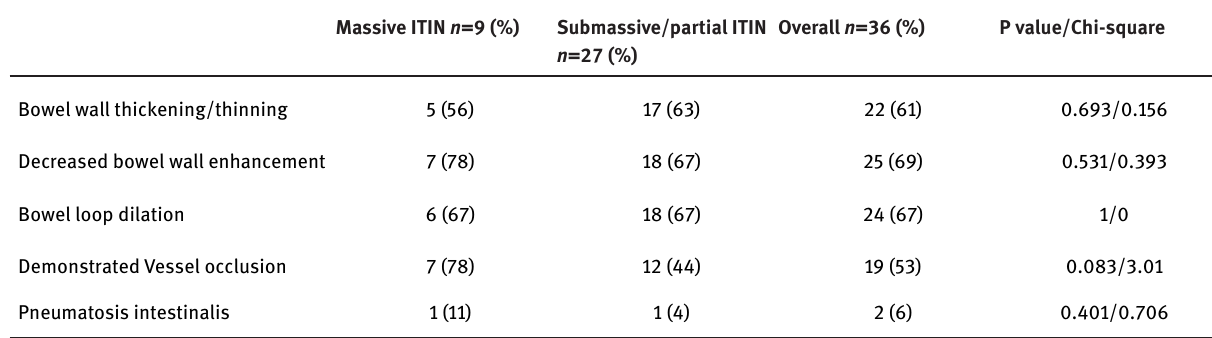
Table 4: Specific CT-scan signs univariate